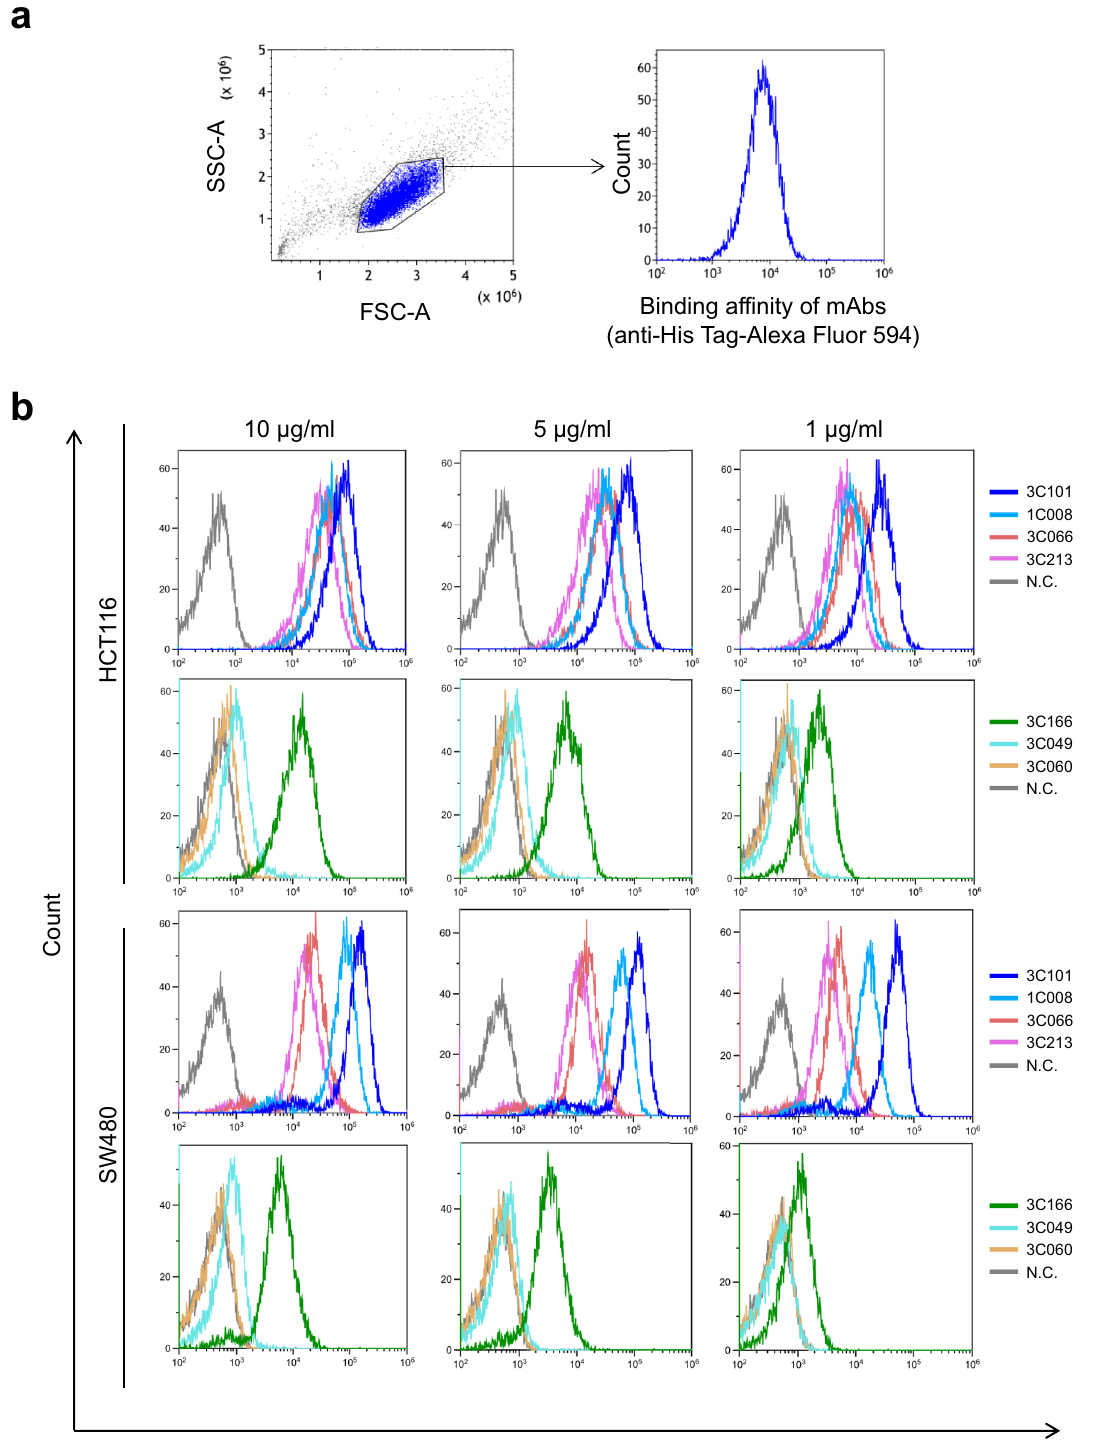
Figure 4. Flow cytometry of monoclonal antibodies. Flow cytometry of mAbs against HCT116 and SW480 cells. ( a ) Gating strategy used in this study. Data are presented in the scatter plot of forward scatter (FSC-A) and side scatter (SSC-A), as well as the histogram indicating Alexa Fluor 488-induced fluorescence intensity. ( b ) Flow cytometry of the selected mAbs. HCT116 and SW480 cells were stained with fully human mAbs at the indicated concentration. Negative control (gray color) indicates the signal with secondary antibody but without primary